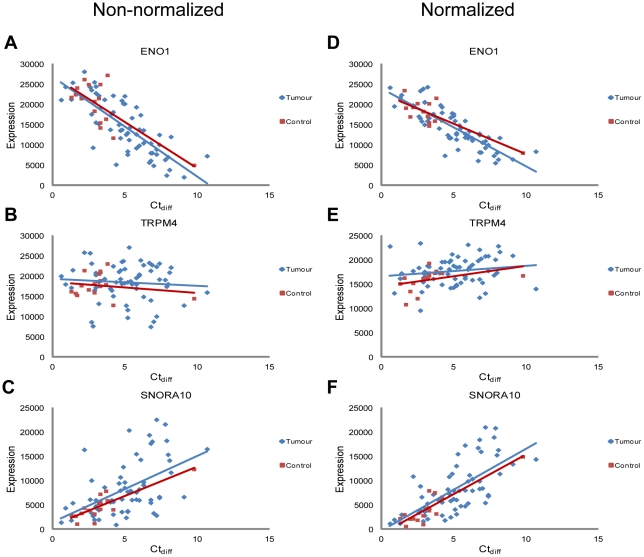
Example of three genes and how their expression was affected by difference in sample quality (Ctdiff).(A), (B) and (C) Linear regression analysis of the genes YPEL5, TRPM4 and the short non-coding gene SNORA10 describing the relationship between expression of the gene and sample quality (CTdiff). All 78 samples are included and analysis was performed using non-normalized data. (D), (E) and (F) Linear regression analysis of the same genes using normalized data. Samples and regression line for tumours are denoted in blue and sample and regression line for controls in red.